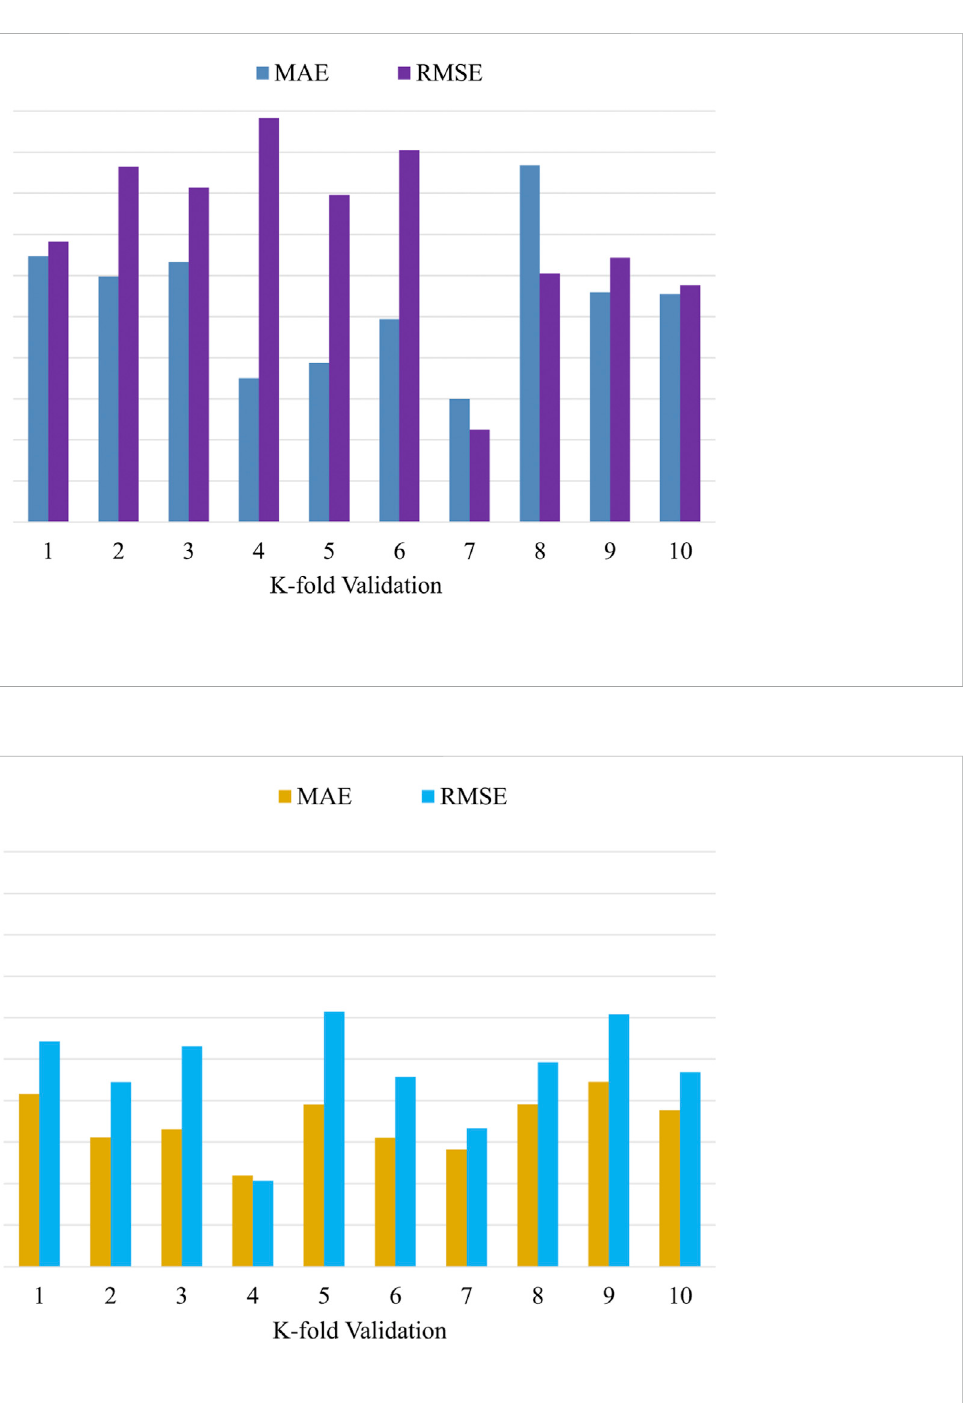
FIGURE 18 GB model statistical